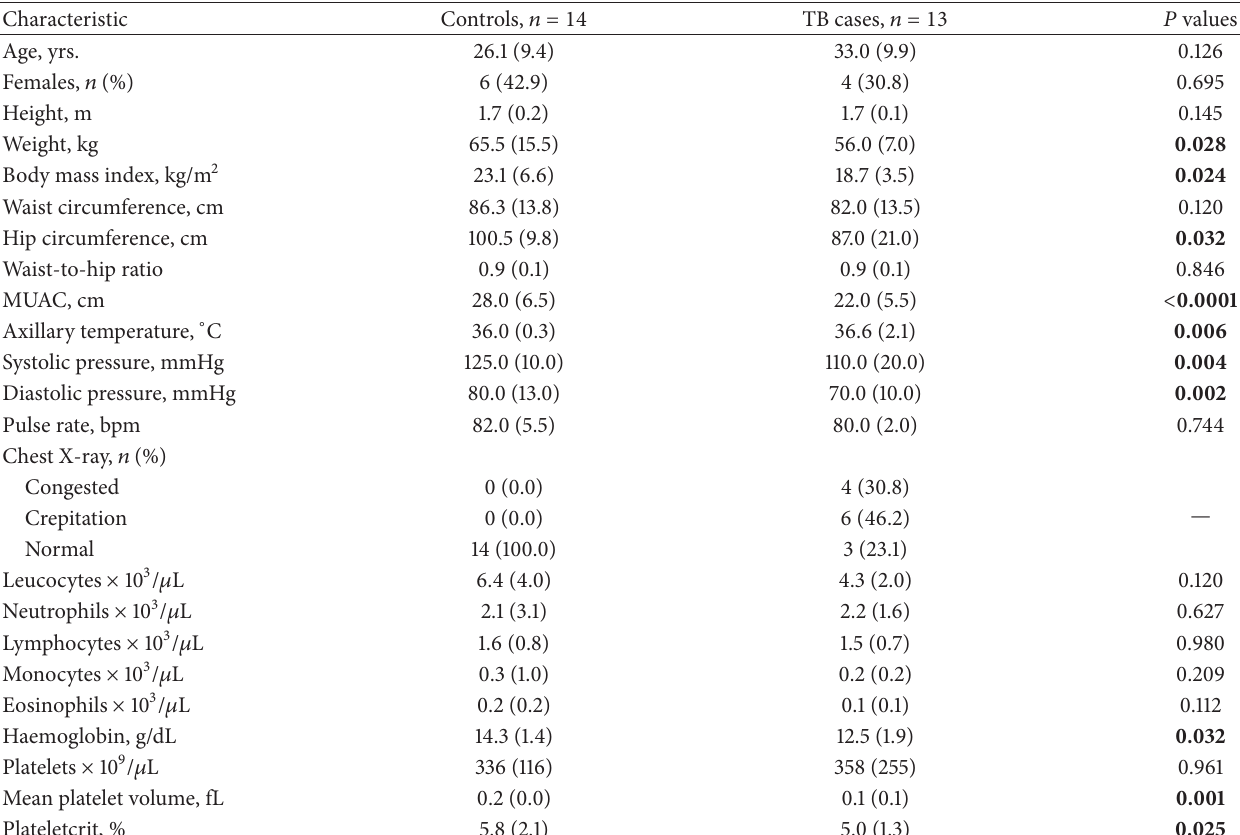
Table 1: Baseline characteristics of the study